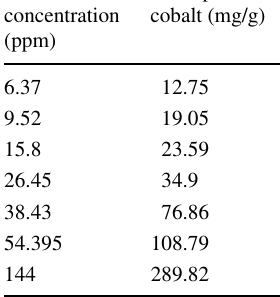
cross-linked chitosan